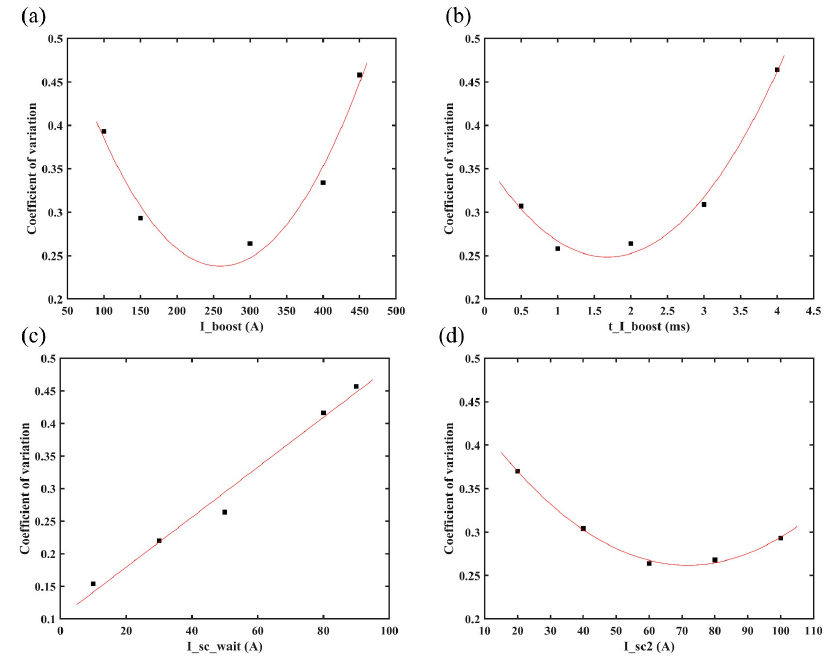
Figure 7. IV SC of CMT deposition process at di ff erent ( a ) I_boost, ( b ) t_I_boost, ( c ) I_sc_wait and ( d ) I_sc2. and ( d )